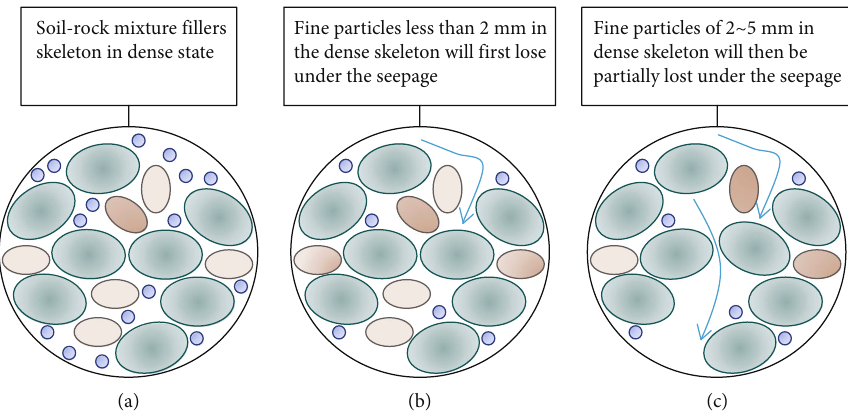
Figure 13: Schematic diagram of the skeleton structure of a binary grain mixture: (a) Status 1; (b) Status 2; (c) Status